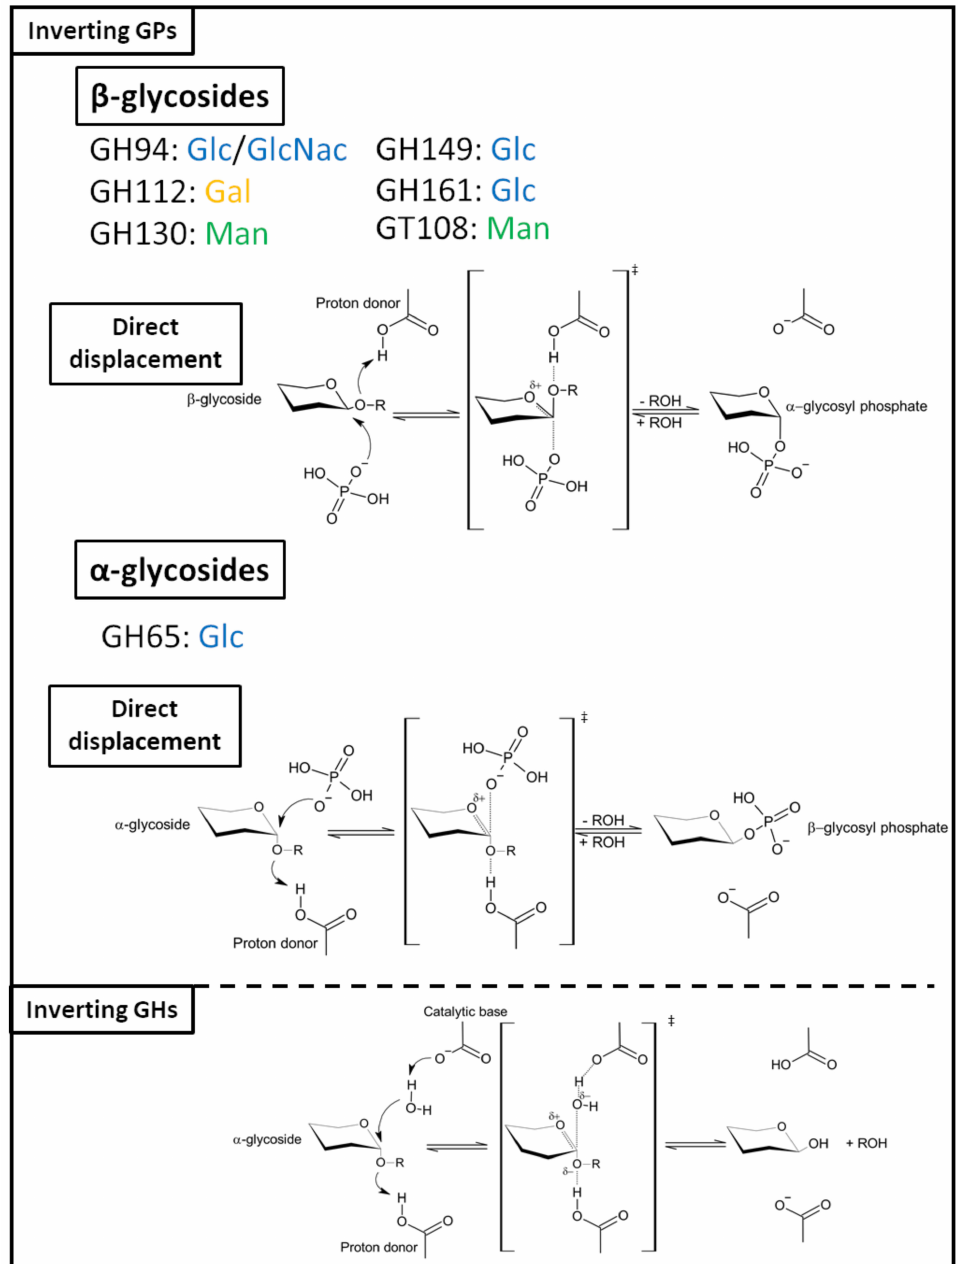
Figure 1. Inverting GPs and GHs catalytic mechanisms and family classification. The carbohydrates indicated for each family correspond to the glycosyl donors used by GPs of this